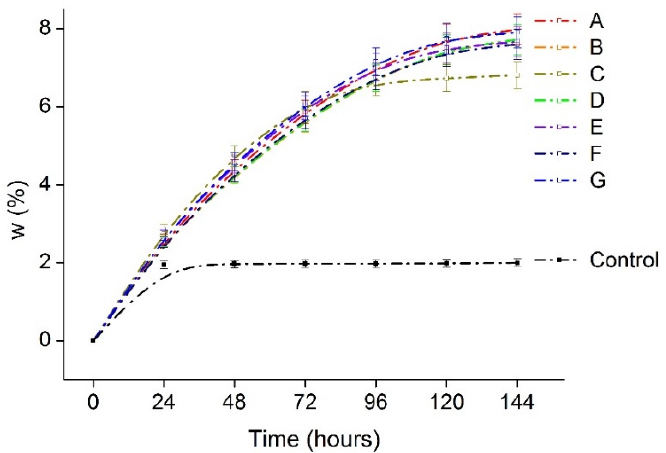
Figure 7. Water vapour absorption rate of the heat pressed films A–G in 90% RH humidity chamber.